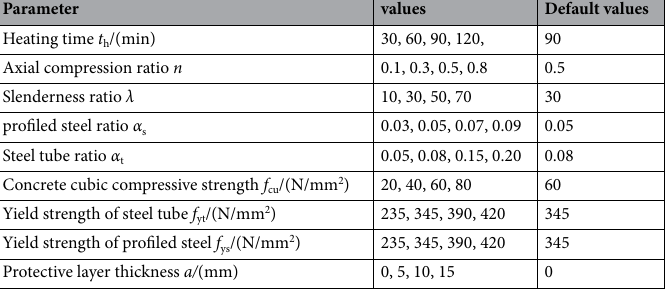
Table 5. Summary of specimen dimensions of the post-non-uniform fire seismic